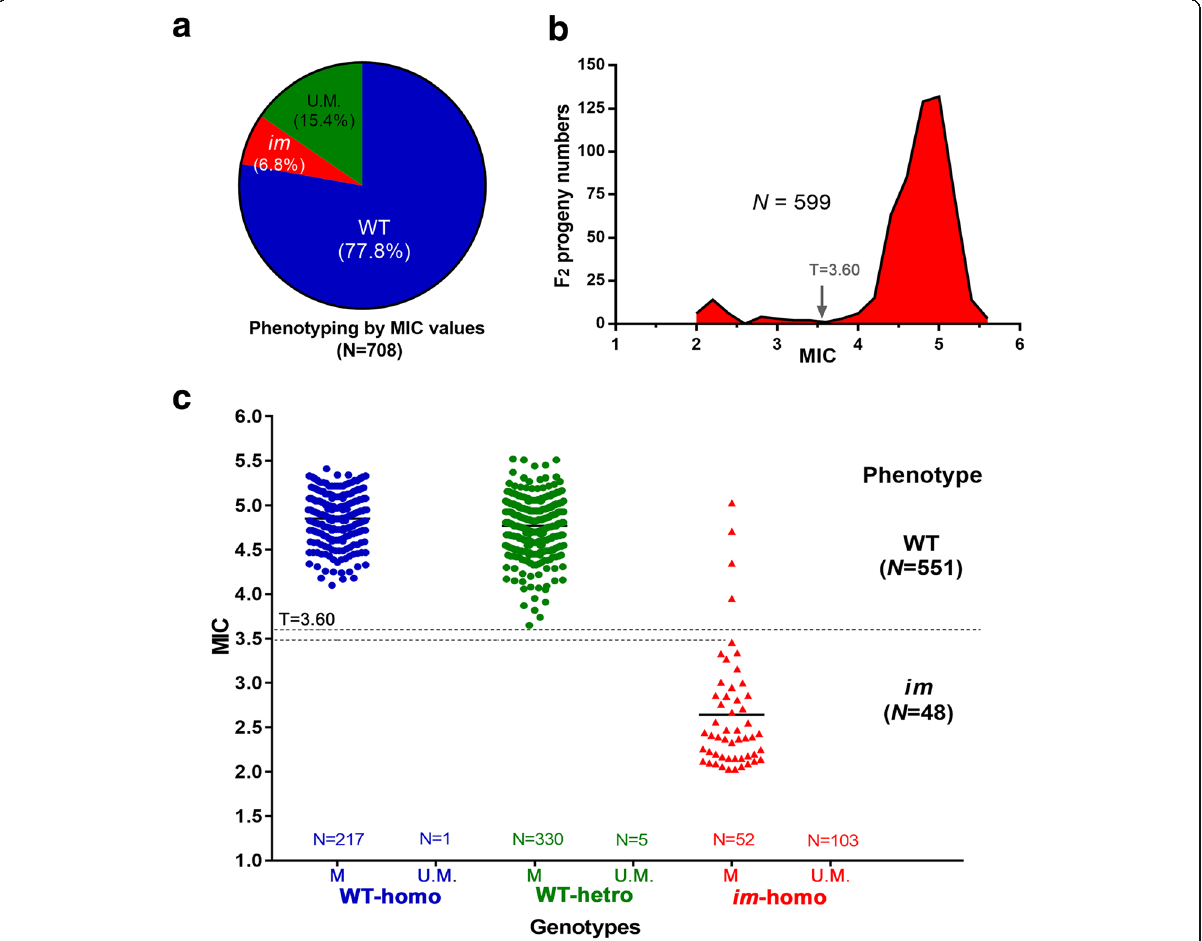
Fig. 2 Phenotyping analysis based on MIC values. a Diagram representing ratios between WT and im phenotypes. MIC values were measured from the 599 plants of the 708 F 2 progeny. b Frequency distribution curve based on MIC values. c Scatter dot plot of comparing genotypes with the MIC-based phenotypes. Genotypes representing homozygous wild type (WT-homo), heterozygous wild type (WT-hetro), and homozygous im type ( im -homo) were determined from DNAs markers. T, threshold value; N, sample number; M, measureable; U.M.,